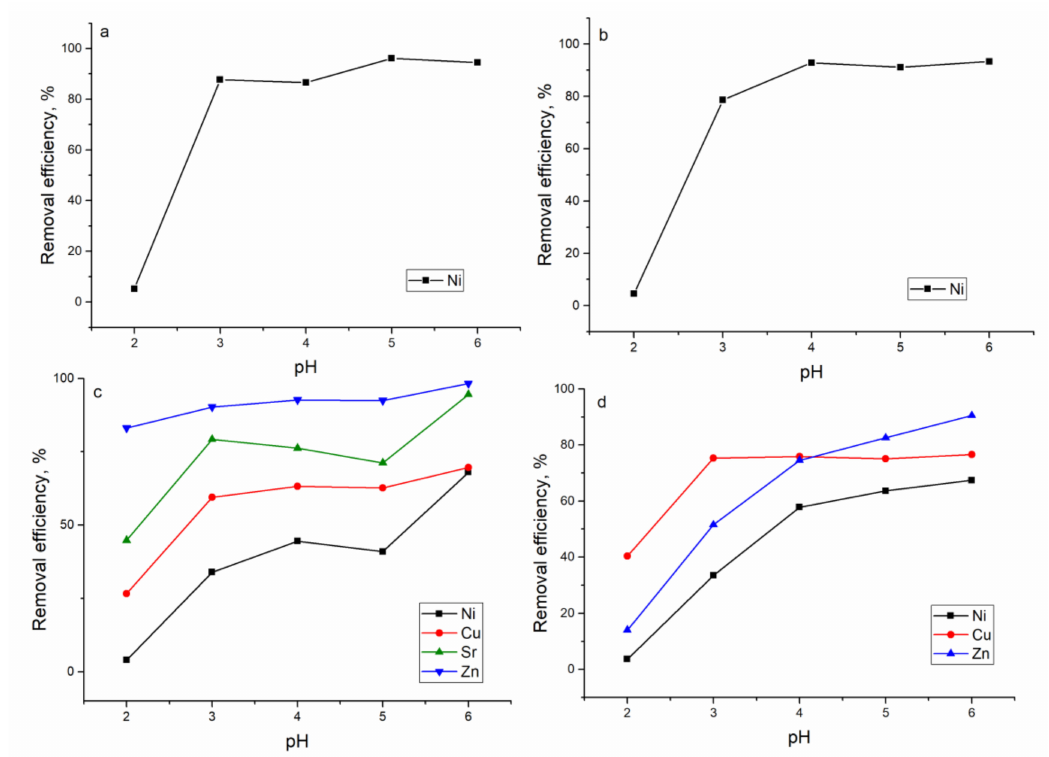
Figure 4. E ff ect of pH on metal removal by hybrid adsorbent: ( a ) Ni(II), ( b ) Ni(II)-Cr(VI)-Fe(III),